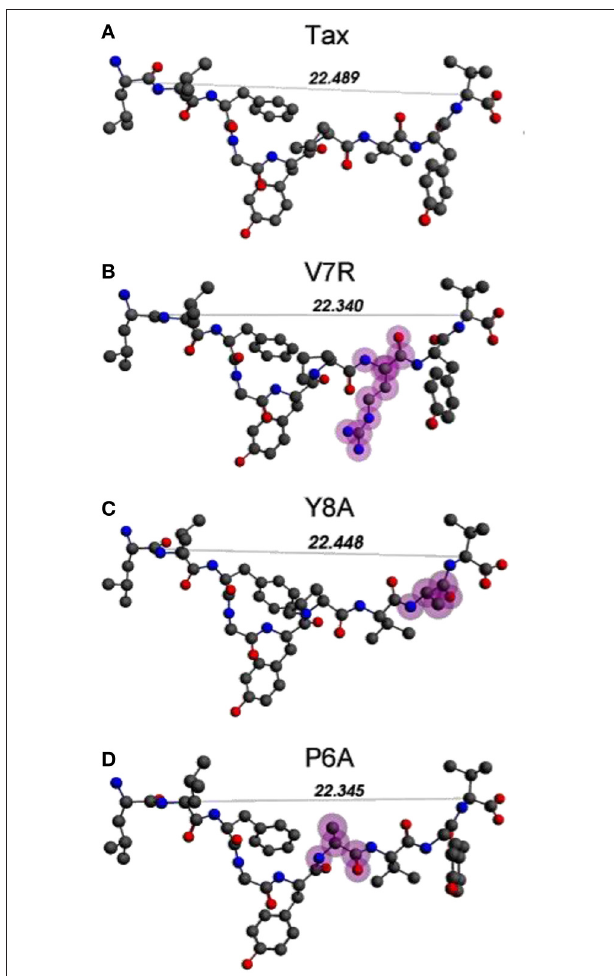
FIGURE 1 | (A–D) Unprotonated structures of the Tax, V7R, Y8A, and P6A, respectively. The TCR alpha and beta chains (not shown) are located underneath the peptides while the MHC alpha chain (also not shown) is located over the peptide and encapsulates it. In all peptides, hydroxyl groups attached to the phenyl side chain of residue 5 point toward the alpha chain of the TCR. In every structure the distance inÅ between the alpha carbon (C α ) atoms of the N- and C-terminus residues are also shown. Atom color notation is C–gray, N–blue, and O–red and is followed throughout. Peptide mutations in respect to Tax are highlighted in